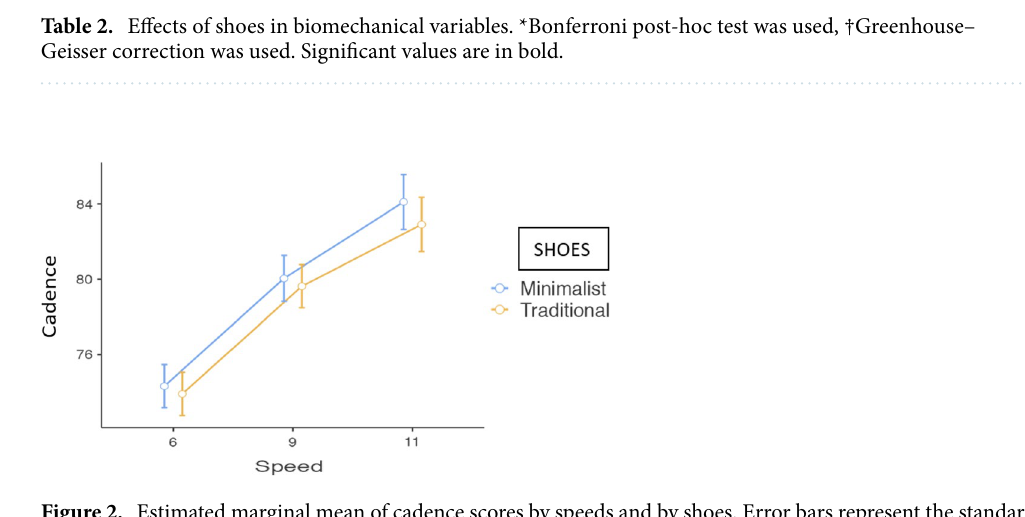
Figure 2. Estimated marginal mean of cadence scores by speeds and by shoes. Error bars represent the standard error of the